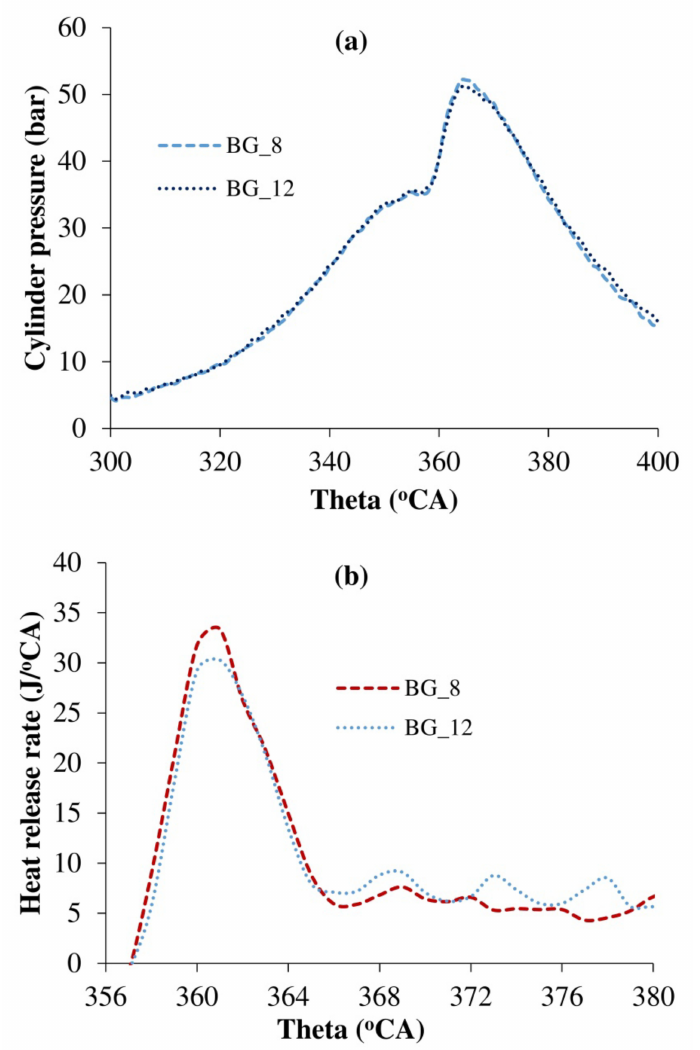
Figure 7. ( a ) Cylinder pressure data and ( b ) heat release rate for various biogas flow rates at 10